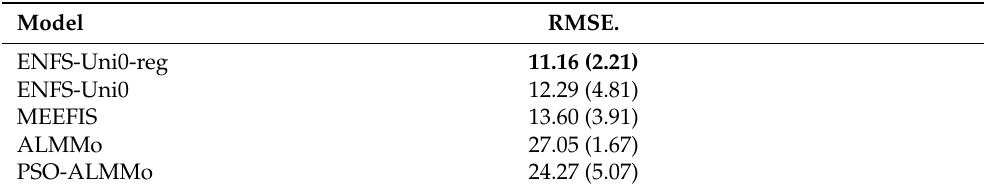
Table 2. Result of wireless sensor network data set (highlighted in bold is the best result).